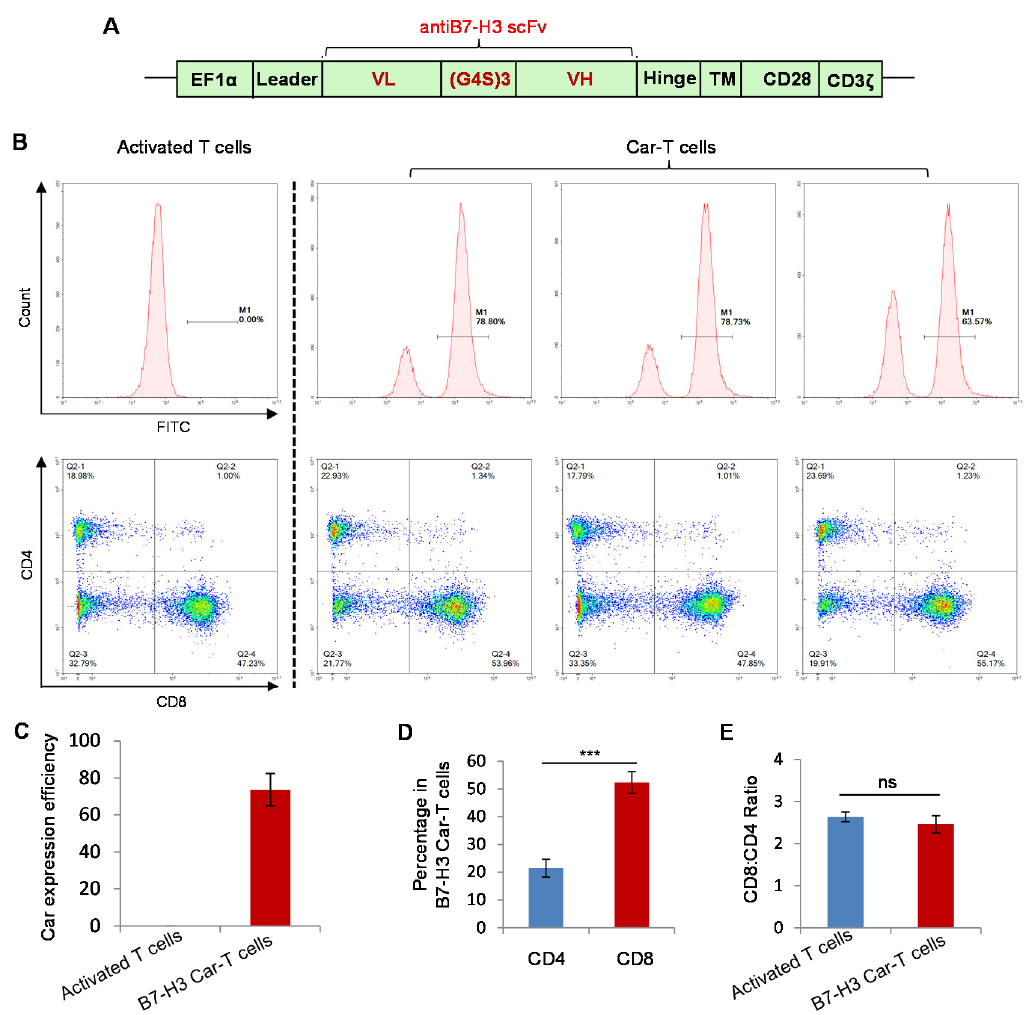
Figure 3. Preparation of B7-H3-targeted CAR-T cells. ( A ) Schematic diagram of the construction of the antiB7-H3 CAR lentiviral vector. ( B – E ) Detection of CAR expression after transfection of activated T cells by lentiviral vector, as well as the analysis of the ratio between CD4 and CD8. Statistical analysis was performed using two-tailed Student’s t test. Experiments were repeated at least three times, and data are expressed as mean ± standard deviation (mean ± SD). ***, p < 0.001; ns, not sig- nificant.